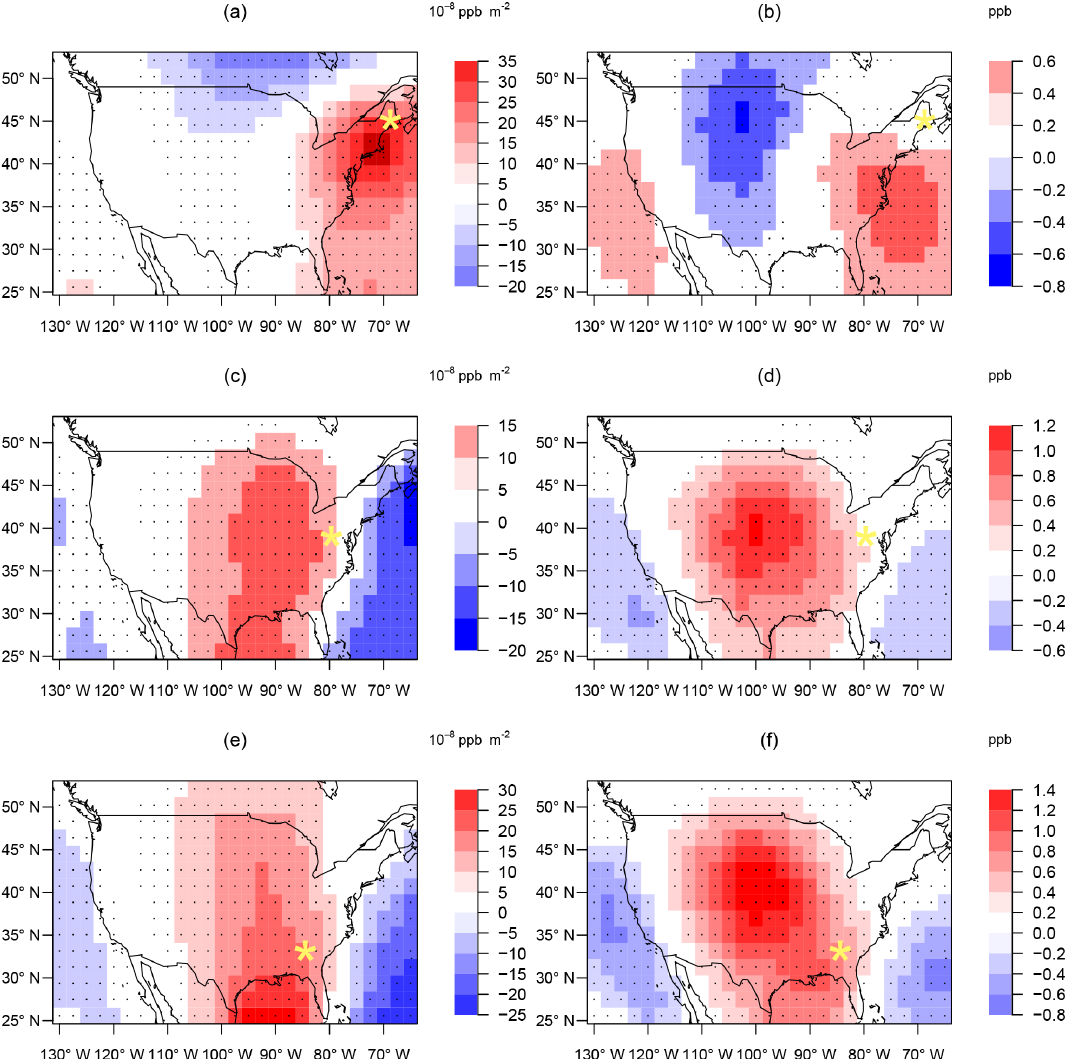
Figure 11. Regression coefficients between MDA8 ozone during JJA at representative sites (star sign) and AWA in the study region (a, c, e) . Regression coefficients multiplied by the change in AWA between the GCM2100 simulation and the GCM2000 simulation (b, d, f) . The predicted change in ozone from the linear regression model is proportional to the sum of all points (in b, d, f ) over the domain (Eq. 6). Stippling represents where the regression coefficient is significant at the 5% significance